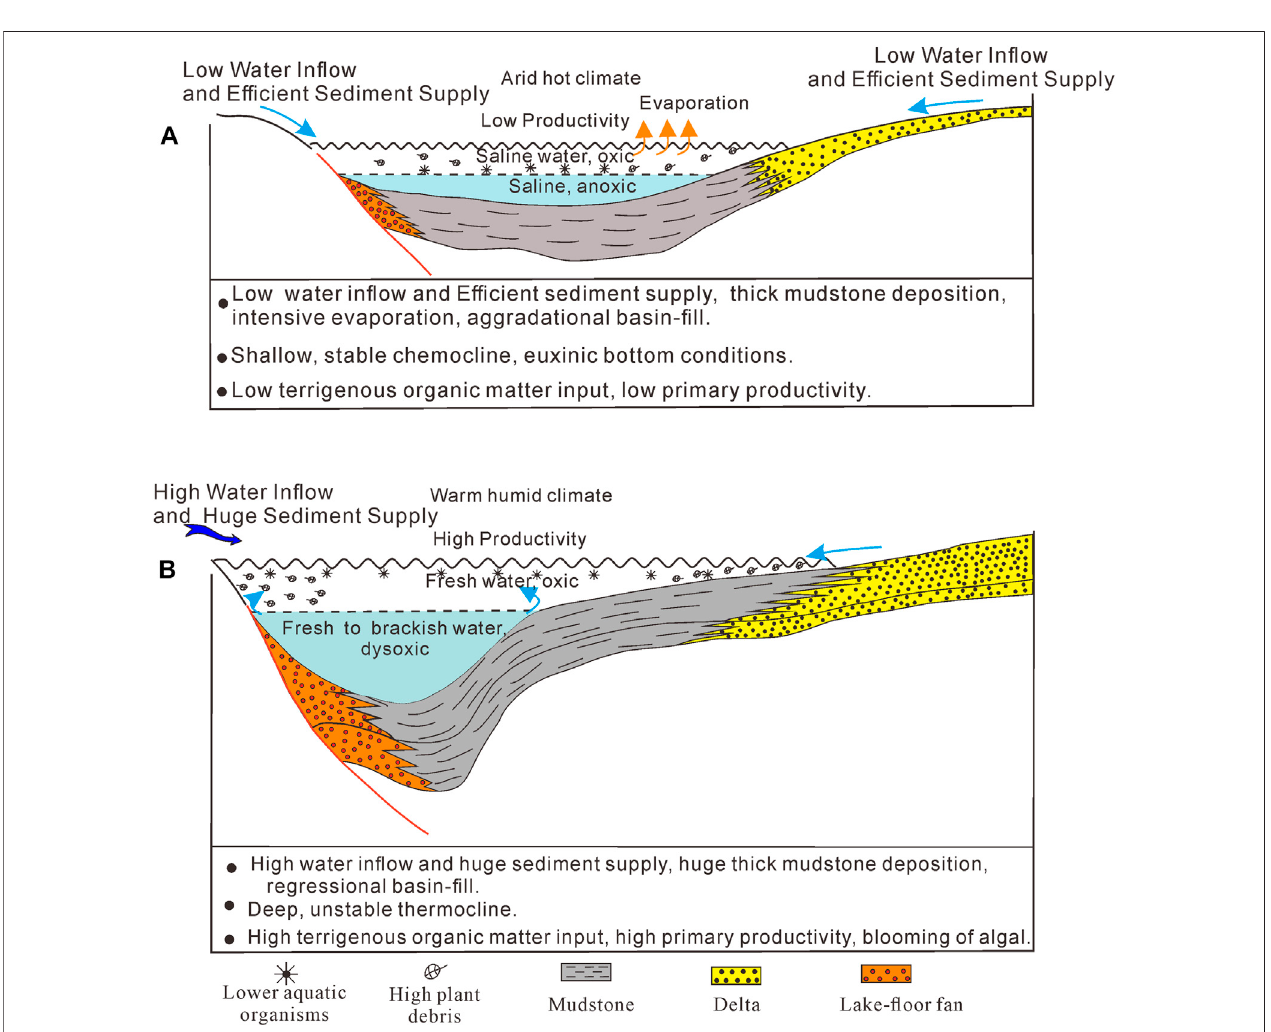
FIGURE14| Depositionalmodelsforthetwosourcerockintervalsshowingtheenvironmentalandecologicalchangesinducedbychangesintectonicsubsidence and climate. (A) Shallow, saline-alkaline lake at Es 4 deposition stage; (B) Deep, fresh lake at Es 3 deposition stage.